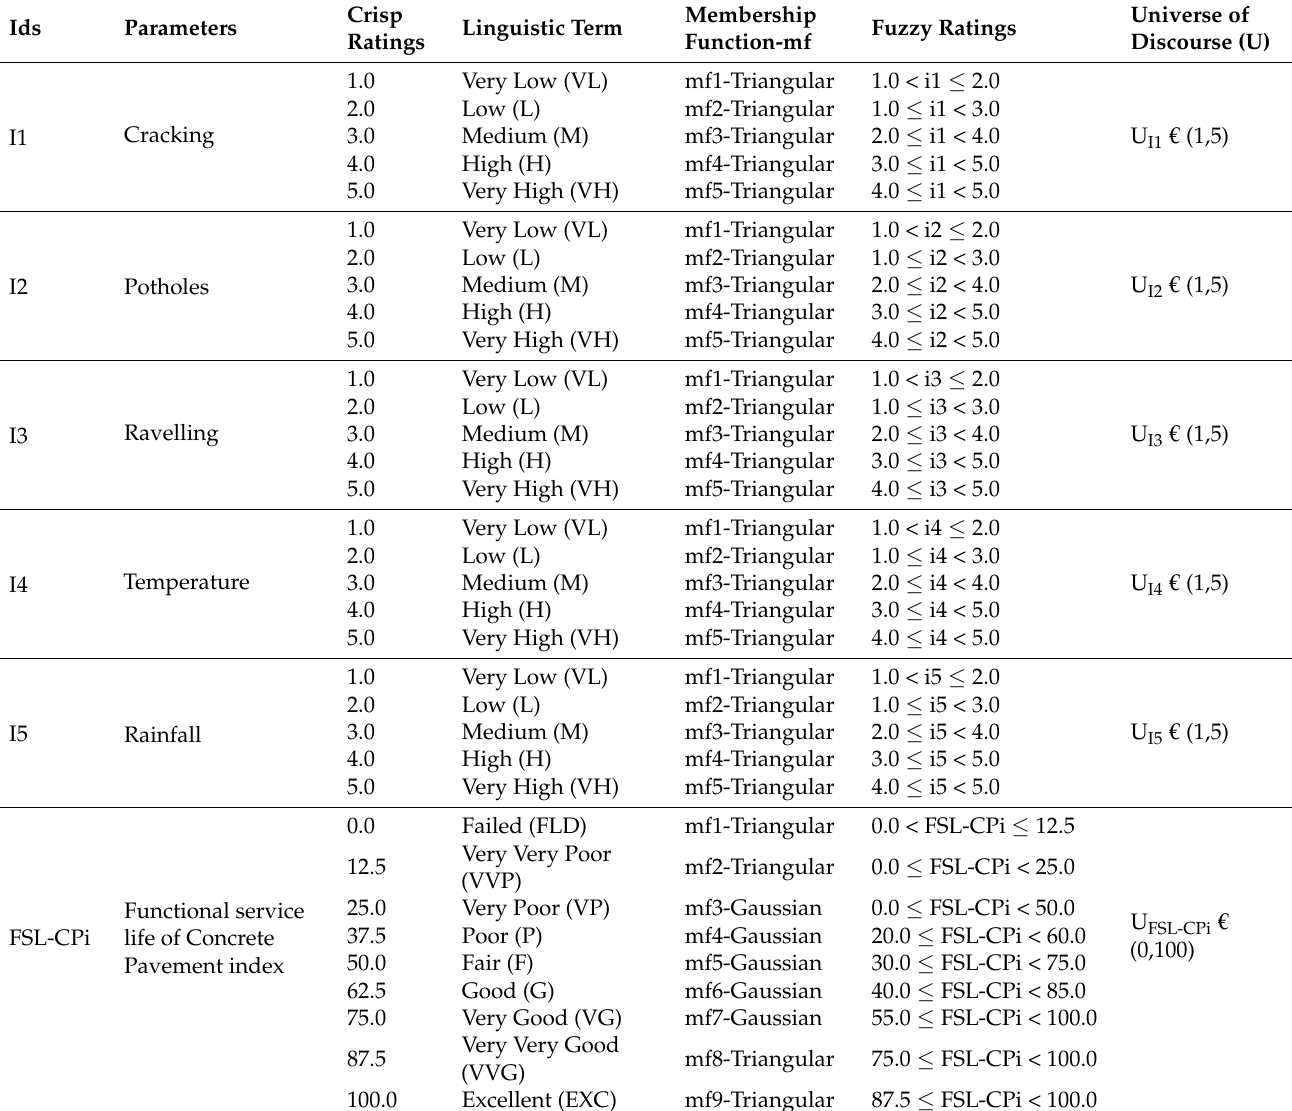
Table 2. Definition of crisp-fuzzy inputs and output variables of the